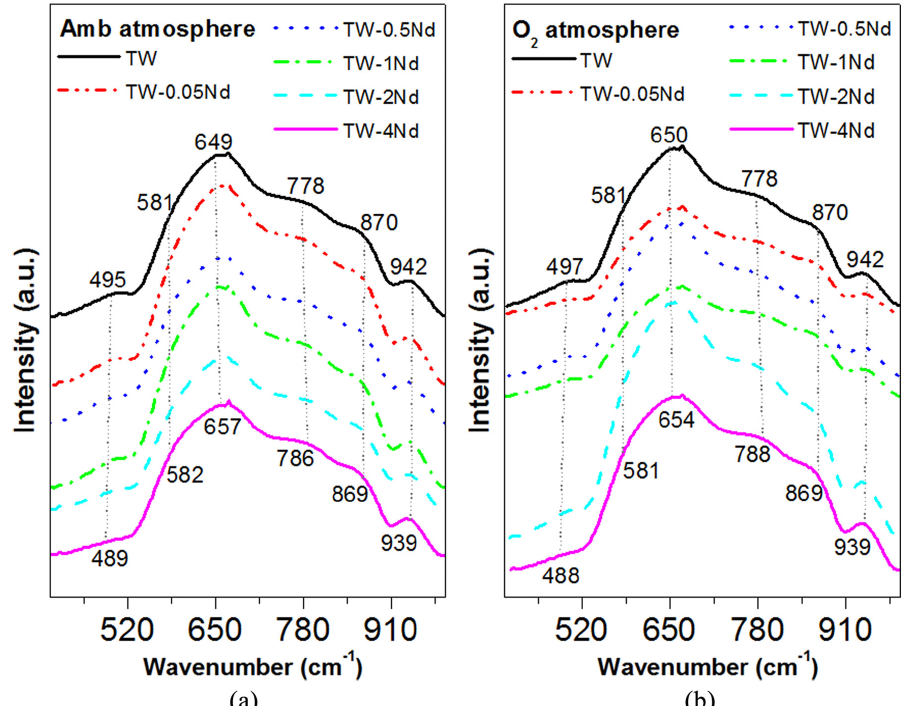
Figure 2. Absorption spectra in the range from 400 to 1000 cm –1 of the Nd 3+ -doped TW glasses prepared in (a) Amb and (b) O